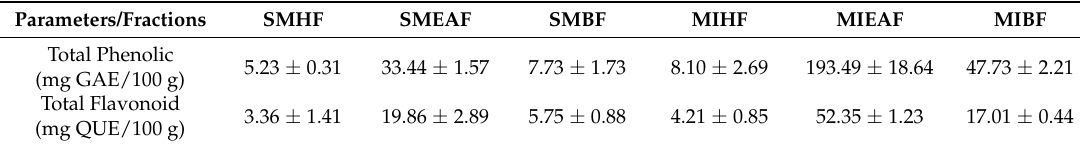
Total phenolic and total flavonoid content of fractions of Spondias mombin and Mangifera indica